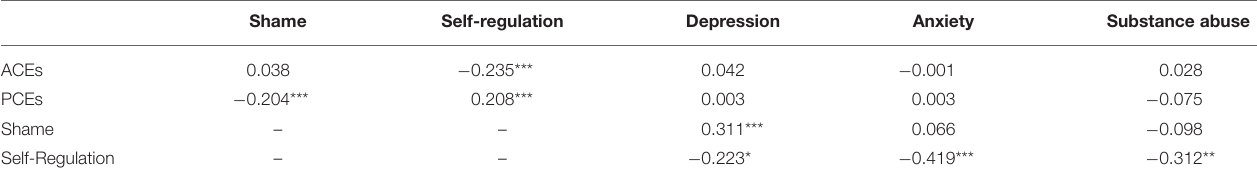
TABLE 2 | Structural equation model results for the role of childhood experiences on shame, self-regulation, and young adult mental health ( N = 489; model fit: RMSEA = 0.049; CFI = 0.946).